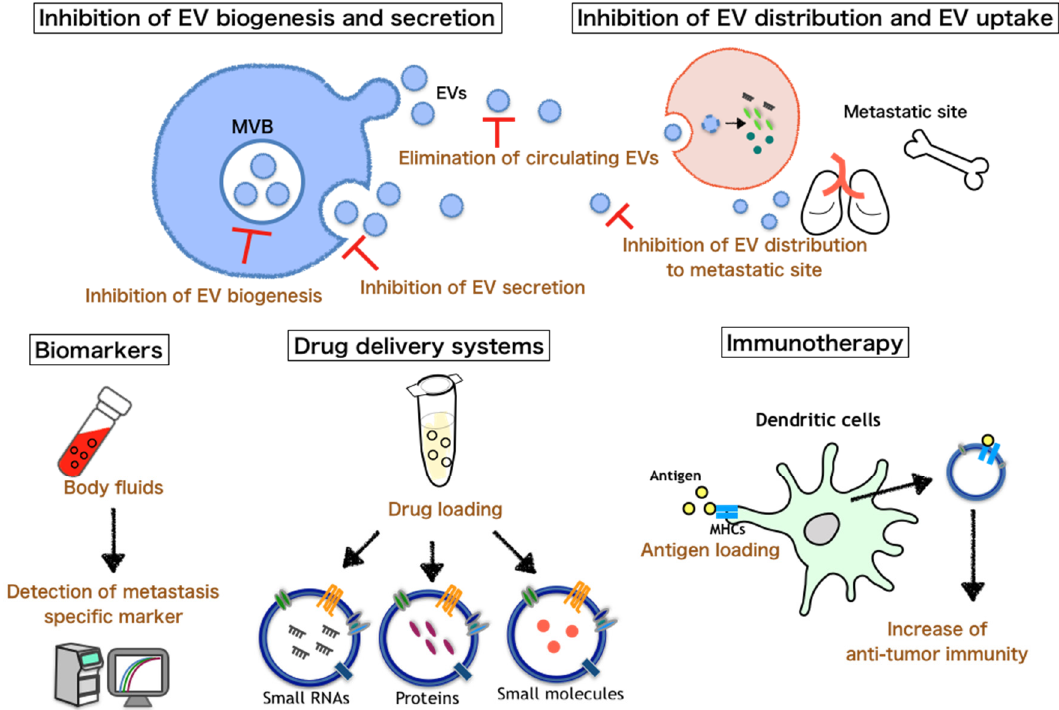
Figure 2. Possible EV engineering for cancer therapy. EVs secreted by cancer cells have a pivotal role in promoting cancer metastasis. Therefore, these EVs could be useful as delivery tools or biomarkers for patients with cancer metastasis.